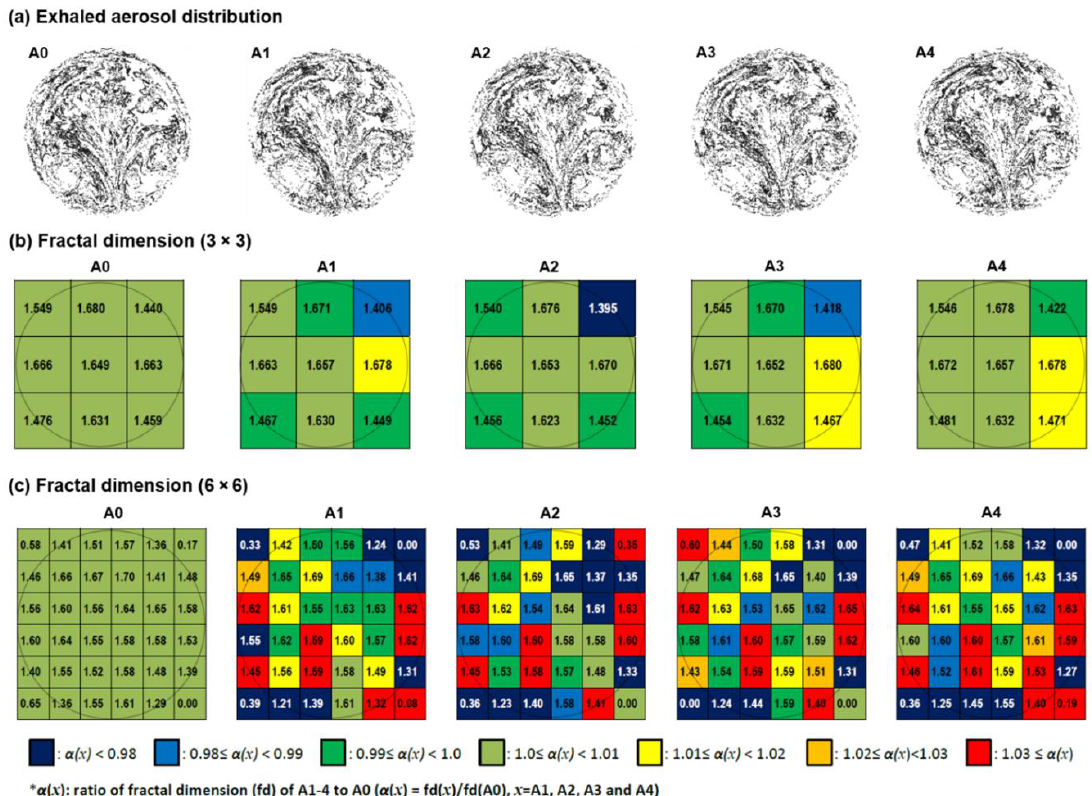
Figure 12. Exhaled aerosol patterns and FD-based feature extraction in the test case 3: ( a ) exhaled AFPs for the five stages of the bronchiolar tumor, ( b ) FD distribution at 3 × 3 resolution, and ( c ) FD distribution at 6 × 6 resolution.